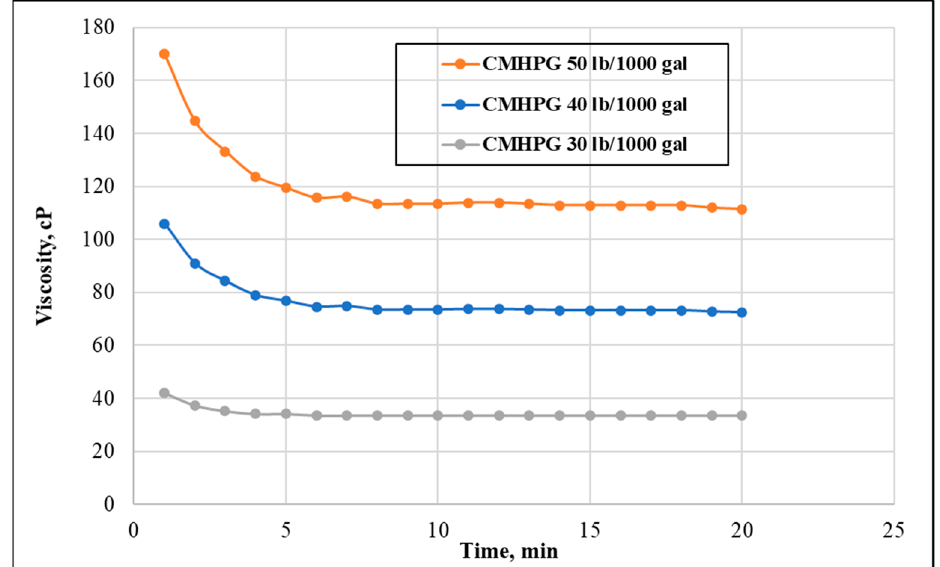
Figure 8. Effect of polymer concentration on the viscosity (shear rate= 100 s − 1 , temperature= 150 °F, and pH = 8).